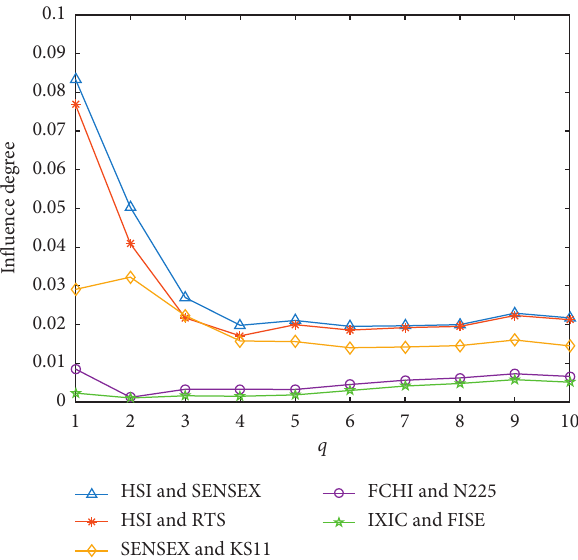
Figure 7: The influence degree of the 2-controlling-variables multifractal detrended partial cross-correlation.